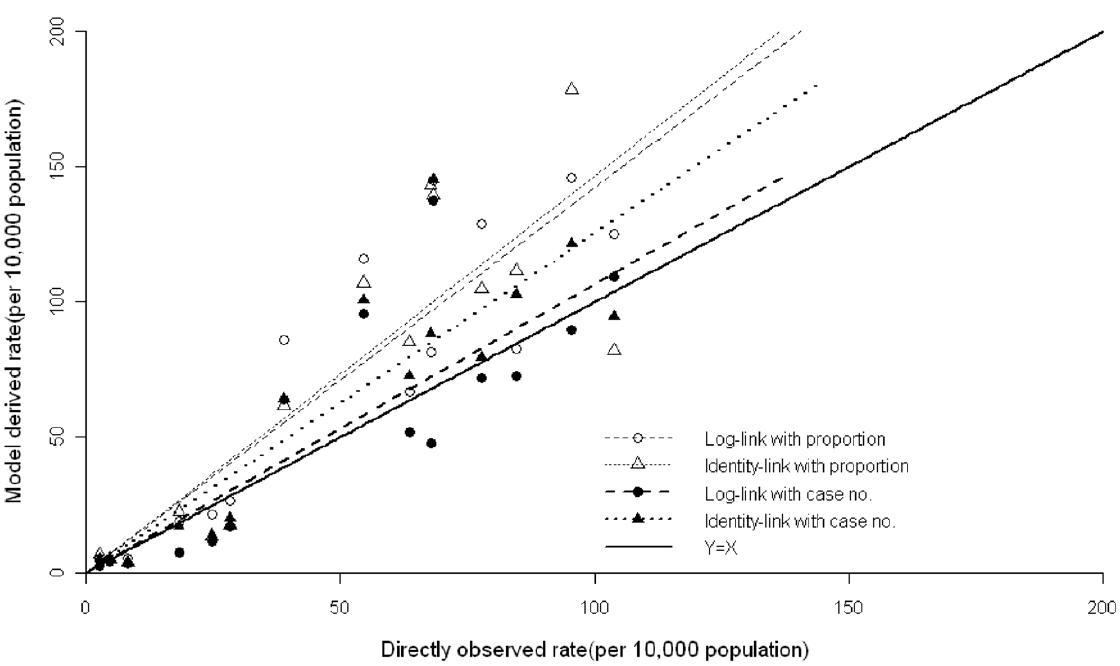
Figure 2. Comparison of age-year specific influenza-associated excess ARD hospitalization rates. The estimates from the log-link Poisson regression with the proportion variables (open circle) and identity-link Poisson with the proportion variables (open triangle) and log-link Poisson with the case number variables (solid circle) and identity-link Poisson models with the case number variables (solid triangle) were plotted against directly observed hospitalization rates with diagnosis of influenza infection. A linear regression line was separately fitted to the estimates derived from each model. The thick black line is the diagonal for y=x.